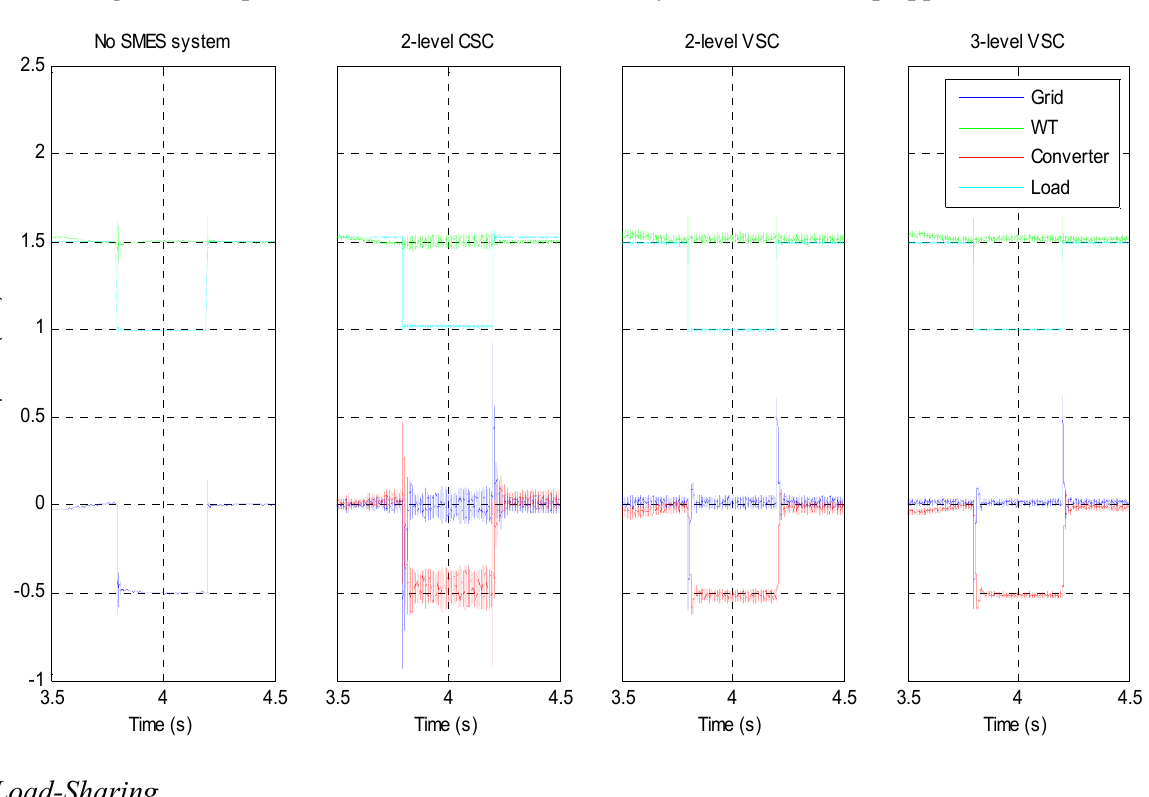
Figure 23. Operation with and without SMES system for load-step